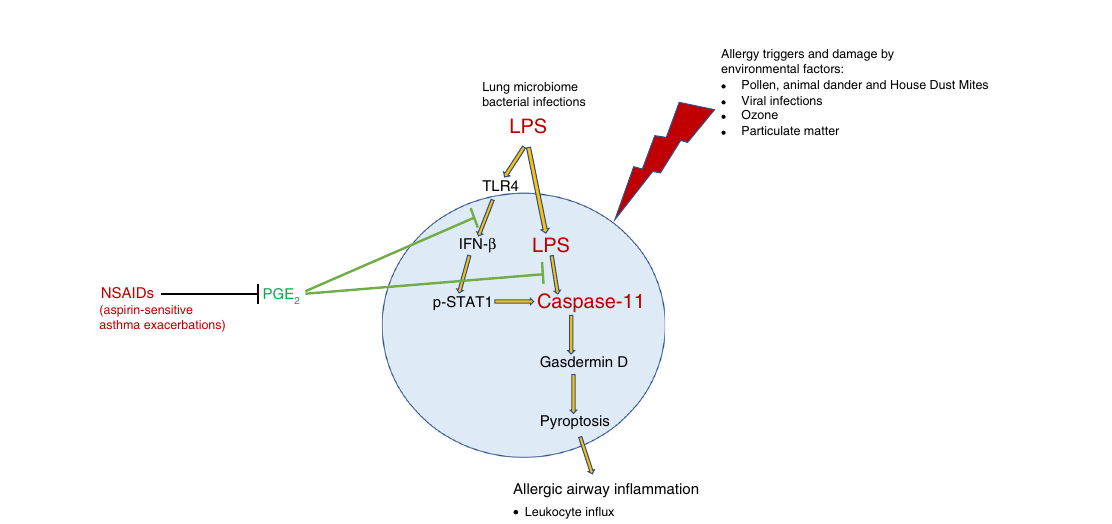
Fig. 5 Caspase-11 drives allergic airway in fl ammation. WT (white bars) and caspase-11-de fi cient (black bars) mice were subjected to allergic airway in fl ammation protocol as explained below. Brie fl y, allergic airway in fl ammation was induced by intraperitoneal injection of 20 μ g of OVA mixed with 2 mg of alum, followed 7 days later by two airway challenges with 1% OVA and lung lysate collection 24 h after the fi nal airway challenge. To discriminate blood- borne circulating cells from lung-localized cells, we used CD45 i.v. administration 10 min before the mouse was killed and lungs were harvested. Lung lavage fl uid was collected and subjected to ( a ) differential cell count. b ELISA analysis. c H&E staining of lung sections. Lungs were homogenized, and cellular in fi ltration as well as cytokine production was analyzed using fl ow cytometry ( d – f ). Data for each mouse tested are shown, with 4 – 5 mice per group, and are represenative of three independent experiments. * P < 0.05, ** P < 0.01, *** P < 0.001 (two-tailed Student ’ s t test, error bars represent mean ± SD). g Blood was collected from control and OVA-treated mice 24 h after the fi nal airway challenge, and serum was isolated and analyzed for IgE levels by ELISA. Two independent experiments were carried out with fi ve mice per group; individual data points on the graph are means from technical duplicates, ** P < 0.01 (two-tailed Student ’ s t test, error bars represent mean ± SD). h Alveolar macrophages from asthmatic or control patients were subjected to qPCR analysis for caspase-4 (eight healthy and seven asthmatic patients, data points on the graph are means from technical duplicates, ** P < 0.01, Mann – Whitney test. Error bars represent mean ± SD).